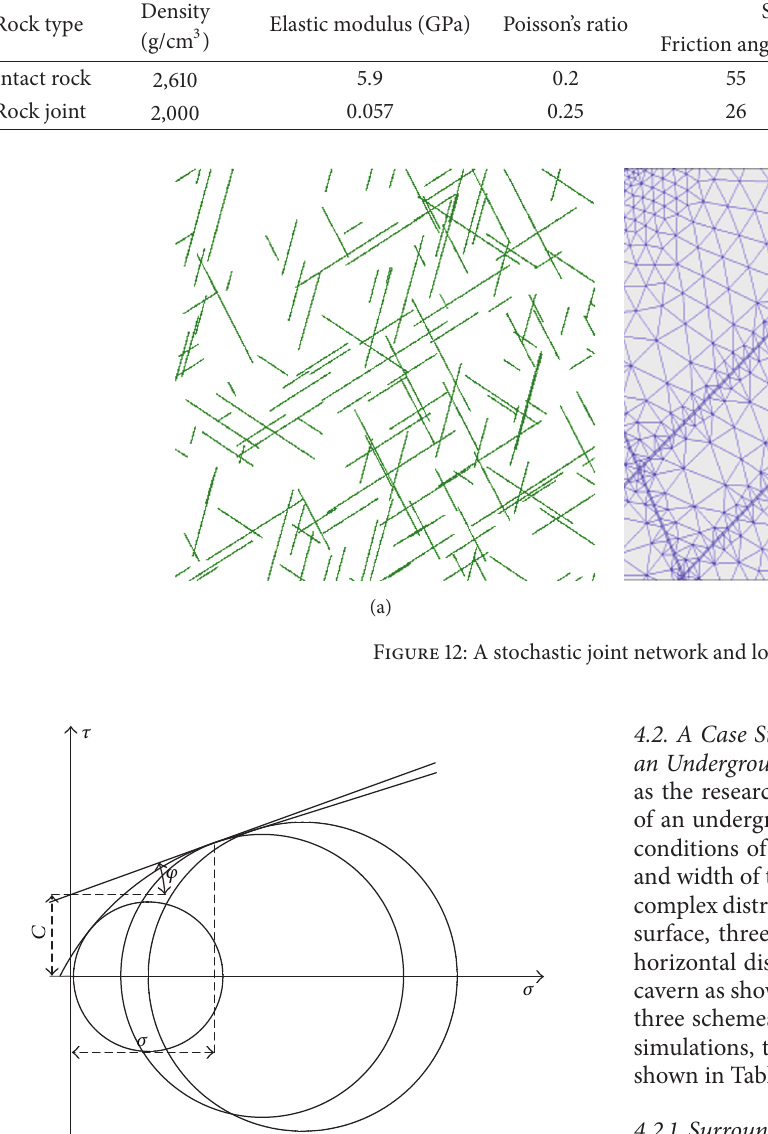
tangent line; 𝜑 is the inner friction angle; 𝑎 is a fitting